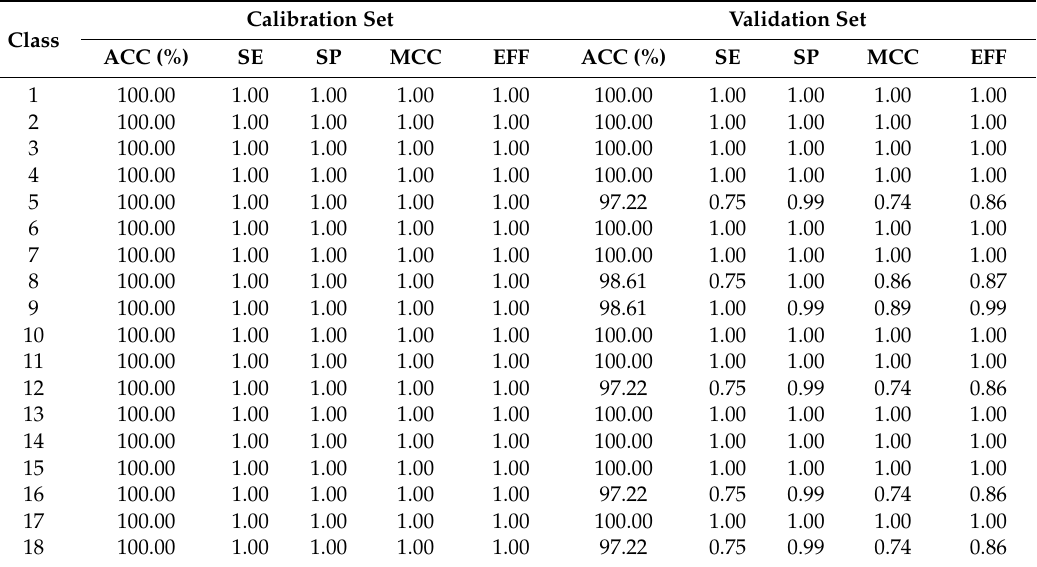
Table 1. The major parameters of random forests (RF) model based on NIR full spectra data. Calibration Set Validation Set Class